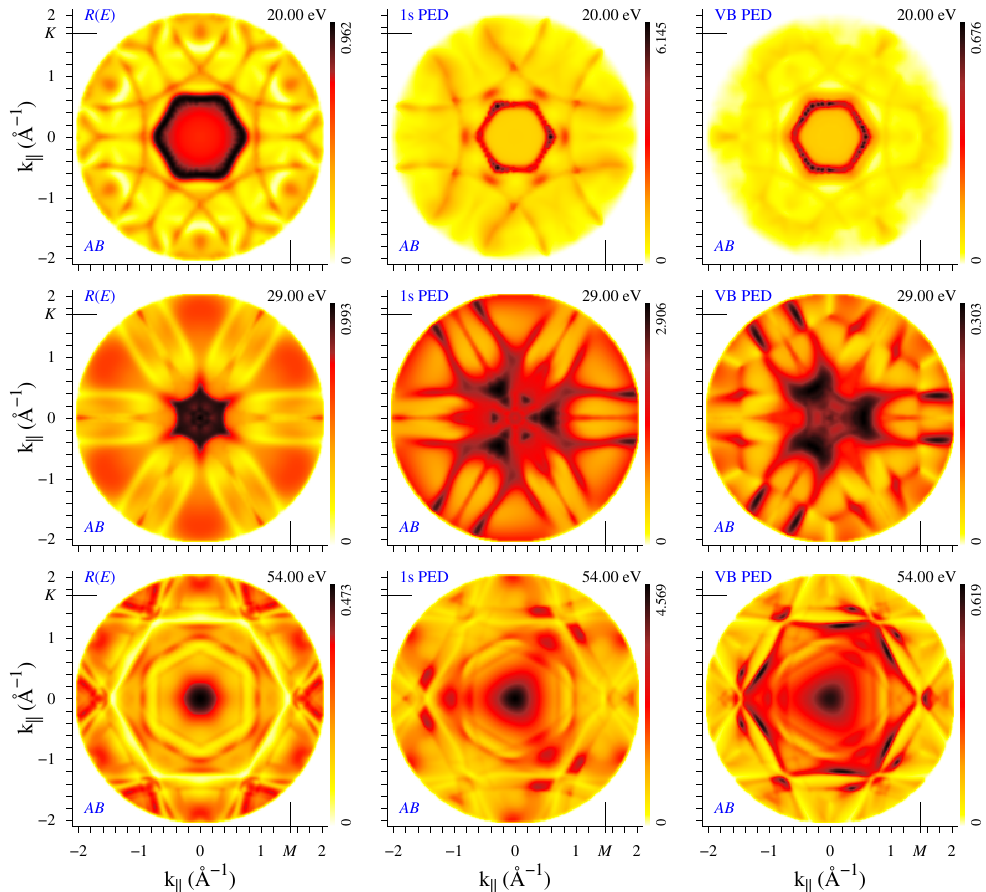
Figure 3. Electron diffraction from the bilayer graphene ( AB stacking), see the caption of Figure 2. The full movie for E = 5 to 59 eV can be found at film2-ABRCV.mov for AB stacking and at film5-TWORC.mov for AA